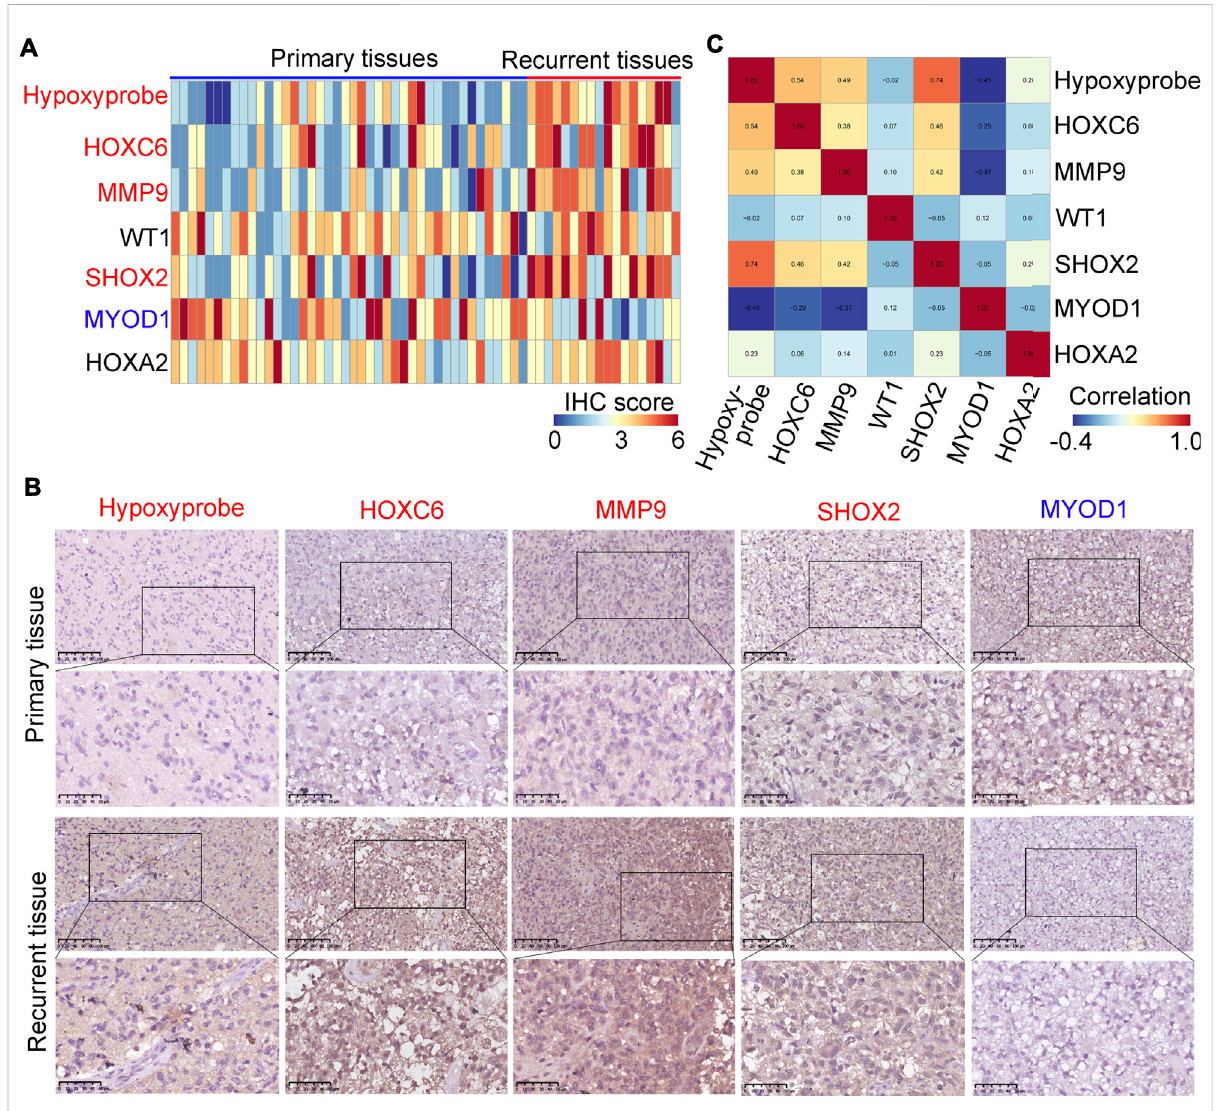
FIGURE 6 Veri fi cation of the expression levels of MYOD1, MMP9, SHOX2, WT1, HOXC6 and HOXA2 in glioma tissues. (A) Expression of hypoxyprobe, HOXC6, MMP9, WT1, SHOX2, MYOD1 and HOXA2 in each glioma tissue ( n = 60). (B) Representative IHC stained images of Hypoxyprobe, HOXC6, MMP9, SHOX2 and MYOD1 in primary and/or recurrent glioma tissues (compared to primary glioma tissues, red gene names in recurrent tissues indicate high expression and blue gene names indicate reduced expression). (C) Co-expressed score of Hypoxyprobe, HOXC6, MMP9, WT1, SHOX2, MYOD1 and HOXA2 in